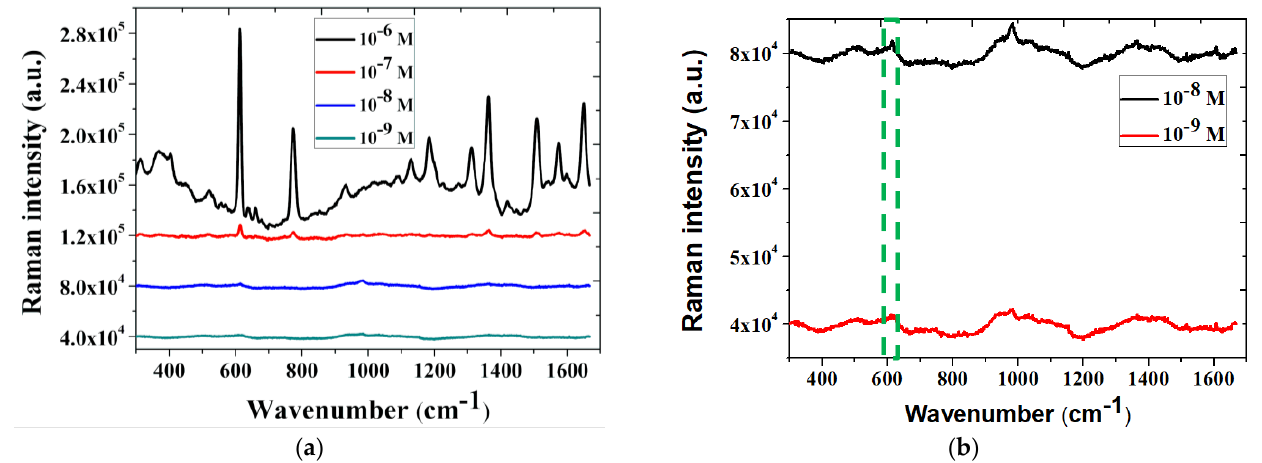
Figure 4. ( a ) The detection limit of R6G on the NPS-AuFON. ( b ) Zoom-in view of the spectra for low concentration conditions.